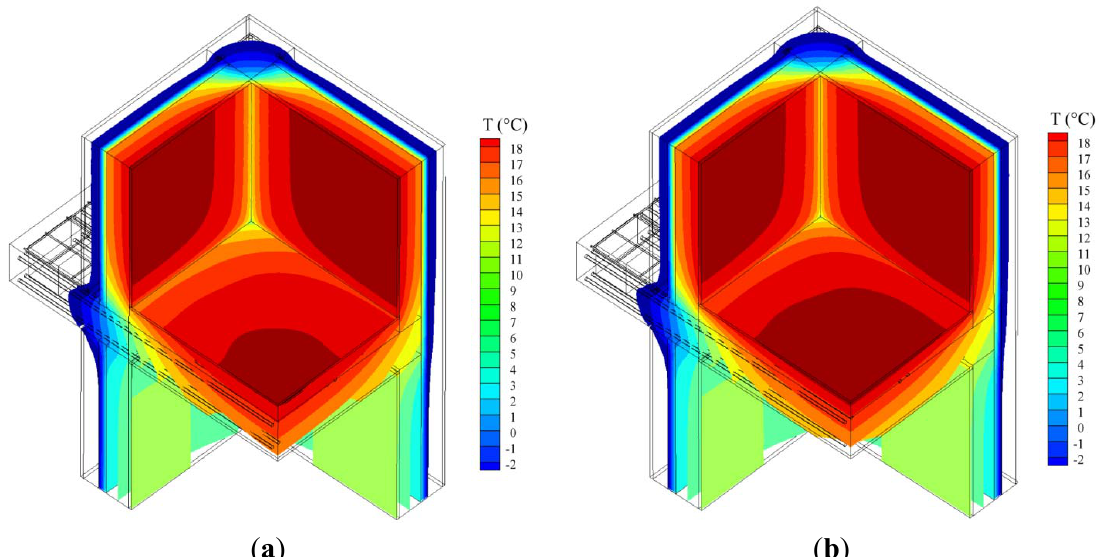
Figure 8. Temperature contours obtained after three days (72 h) employing two different ( a ) and C ( b concrete mixtures: C 0 30